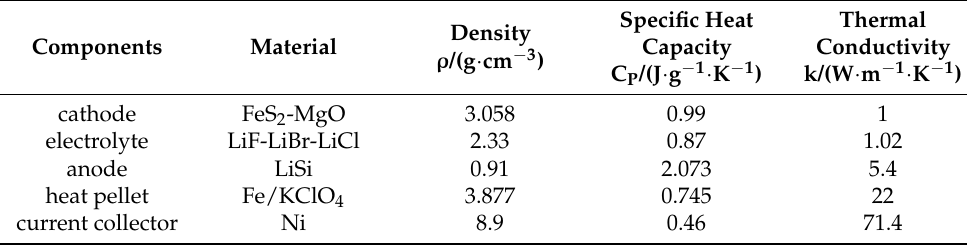
Table 1. Table of the main material